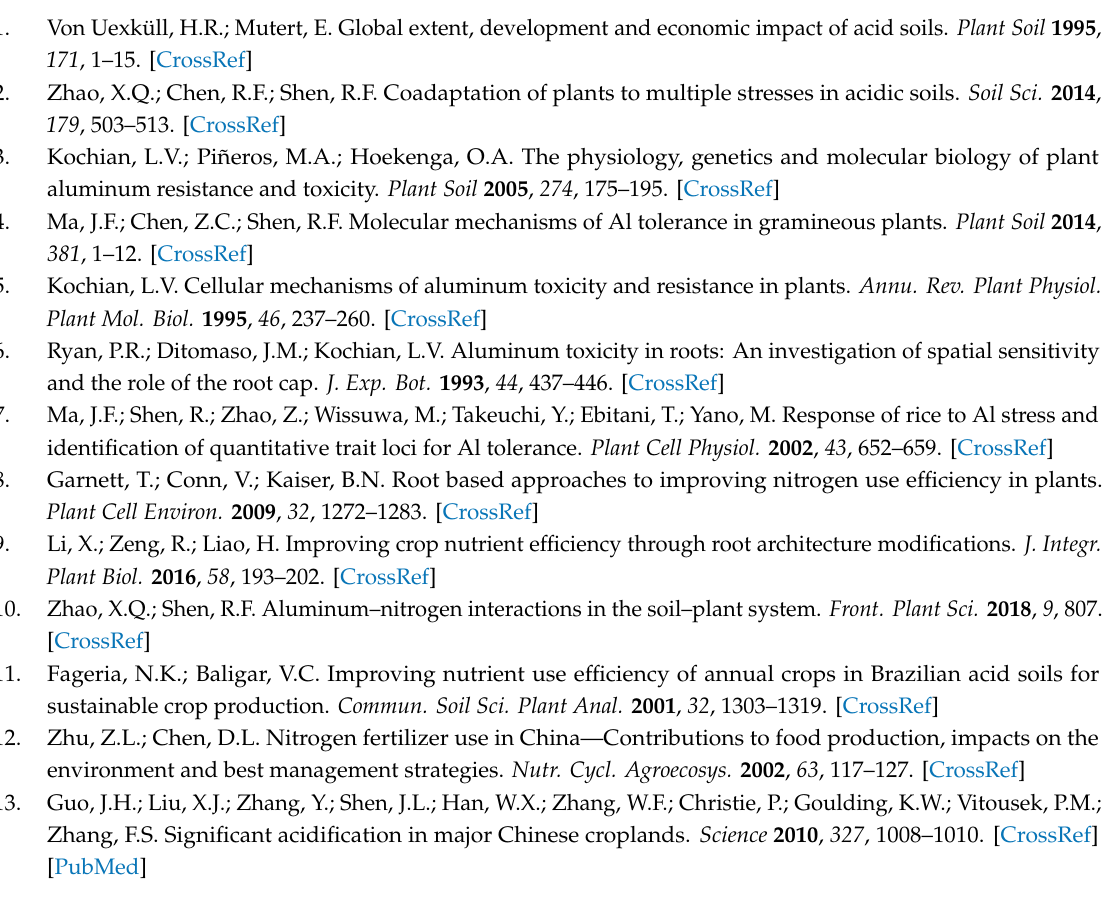
Table S1: Analysis of variances of the e ff ects of liming practice (L), N fertilization (N), di ff erent rice cultivars (C) and their interactions ( P value), Figure S1: Correlation analyses of root–shoot ratio with nitrogen (N) concentration in rice, Figure S2: Correlation analyses of root dry weight with N uptake in